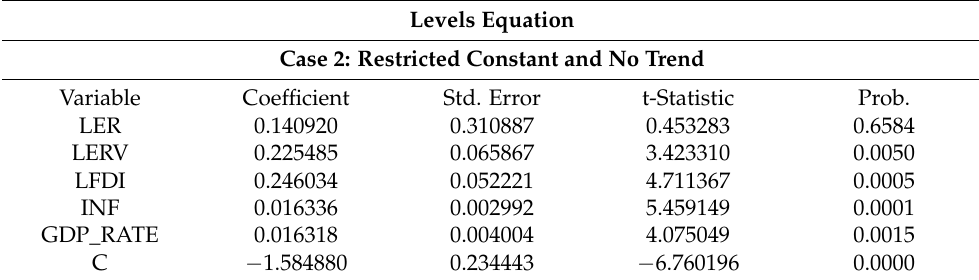
Table 5. Long-term estimation of the model (trade